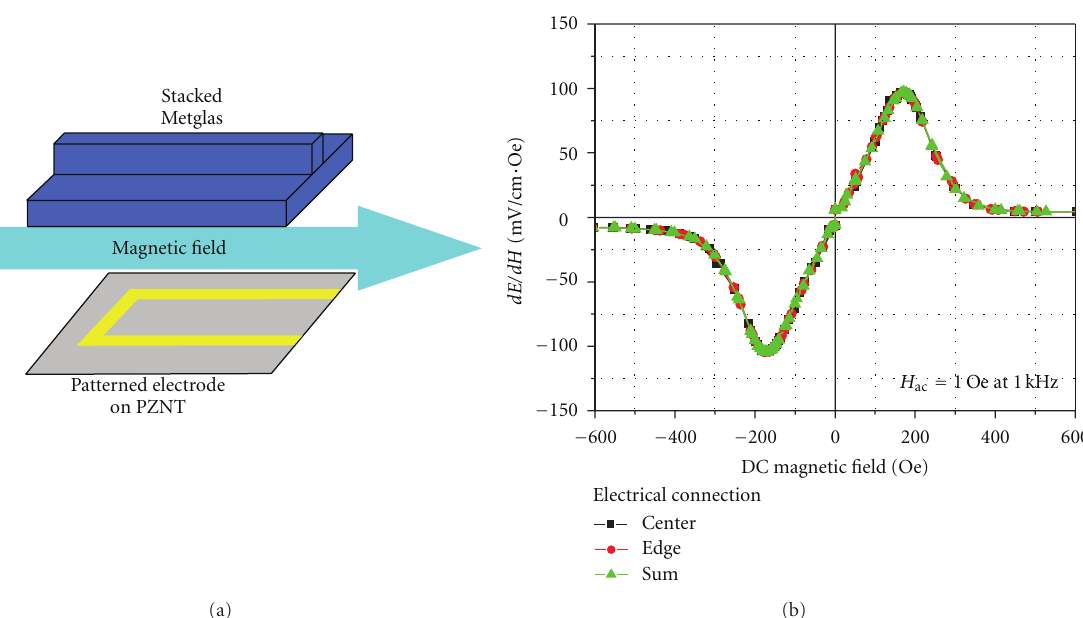
Figure 4: (a) Schematic representation of sample preparation with pyramid-shaped Metglas structure on separately electroded PZNT plate. (b) Magnetoelectric coe ffi cients depending on electrical connections [11].